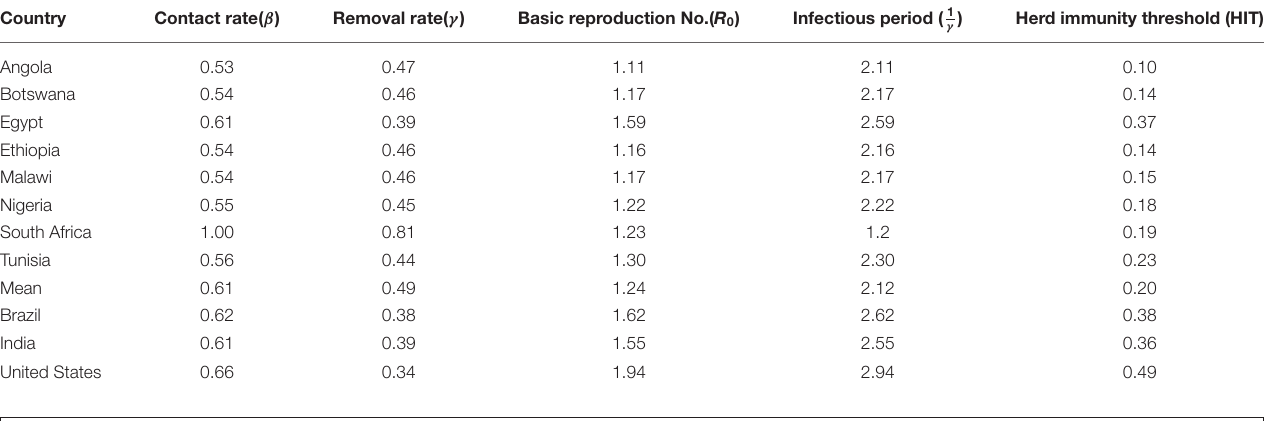
) Herd immunity threshold (HIT) γ